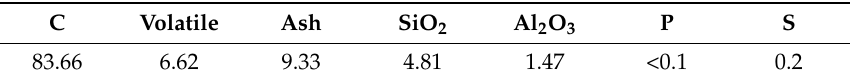
Table 3. Chemical composition of the industrial pulverized coal (wt. %).